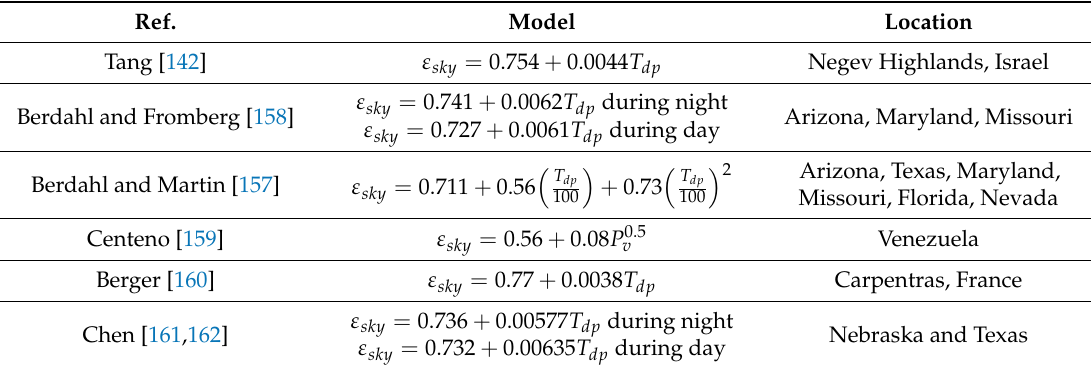
Table 4. Different expressions for sky